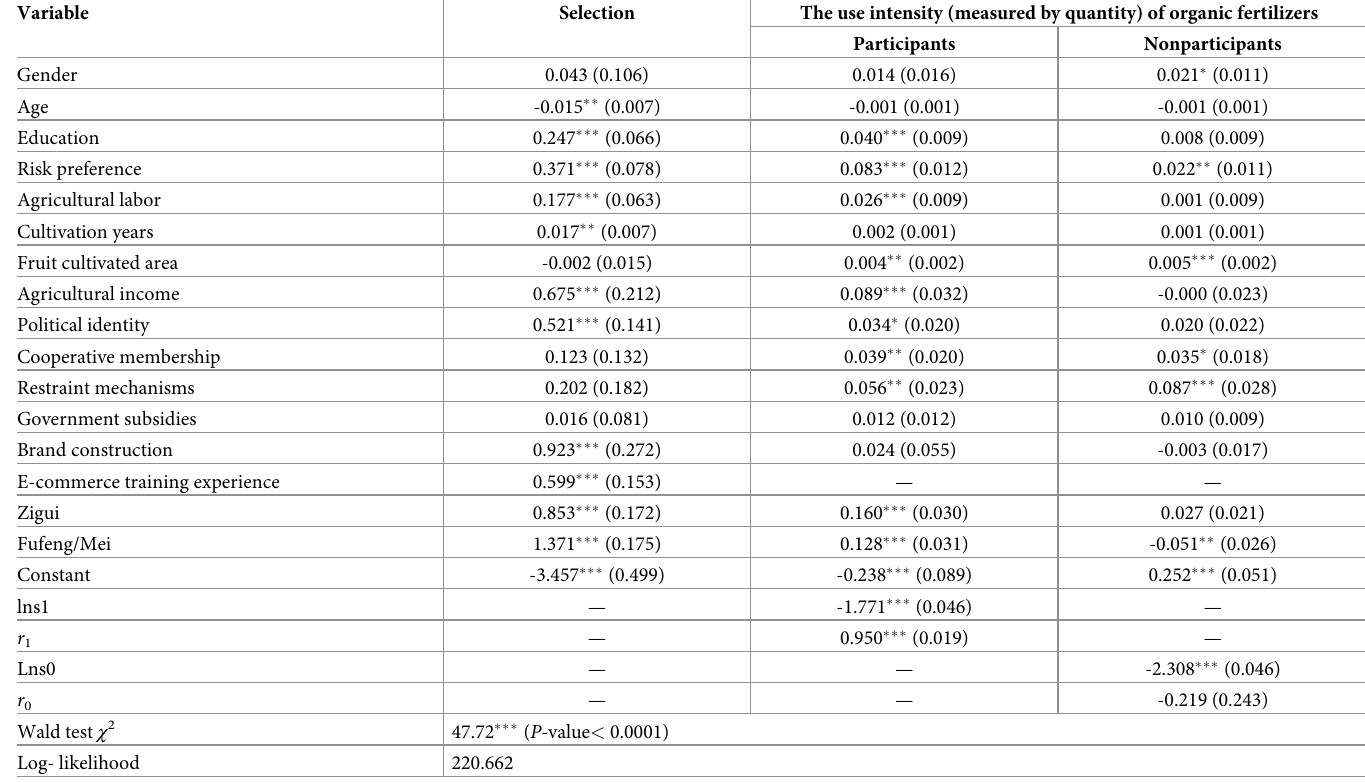
Table 3. Determinants of e-commerce participation and determinants of the use intensity (measured by quantity) of OF.